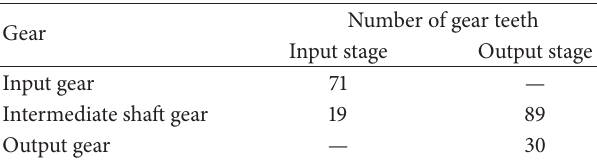
Table 4: Planetary gearbox configuration parameters. Gear Number of gear teeth Ring 96 Planet 37 (3)